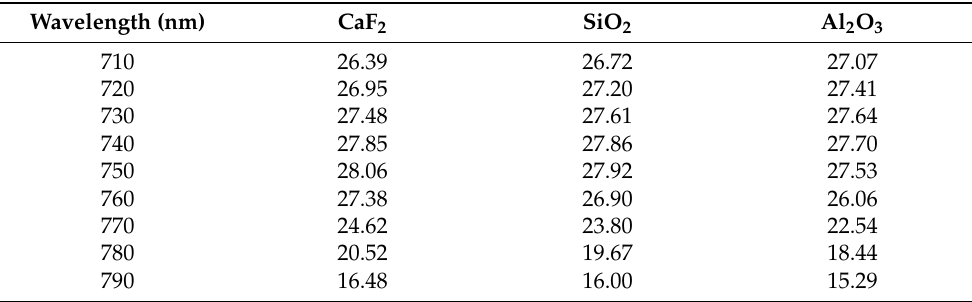
Table 5. Effect of using various materials as an anti-reflective coating on the efficiency of the inverted planar perovskite solar